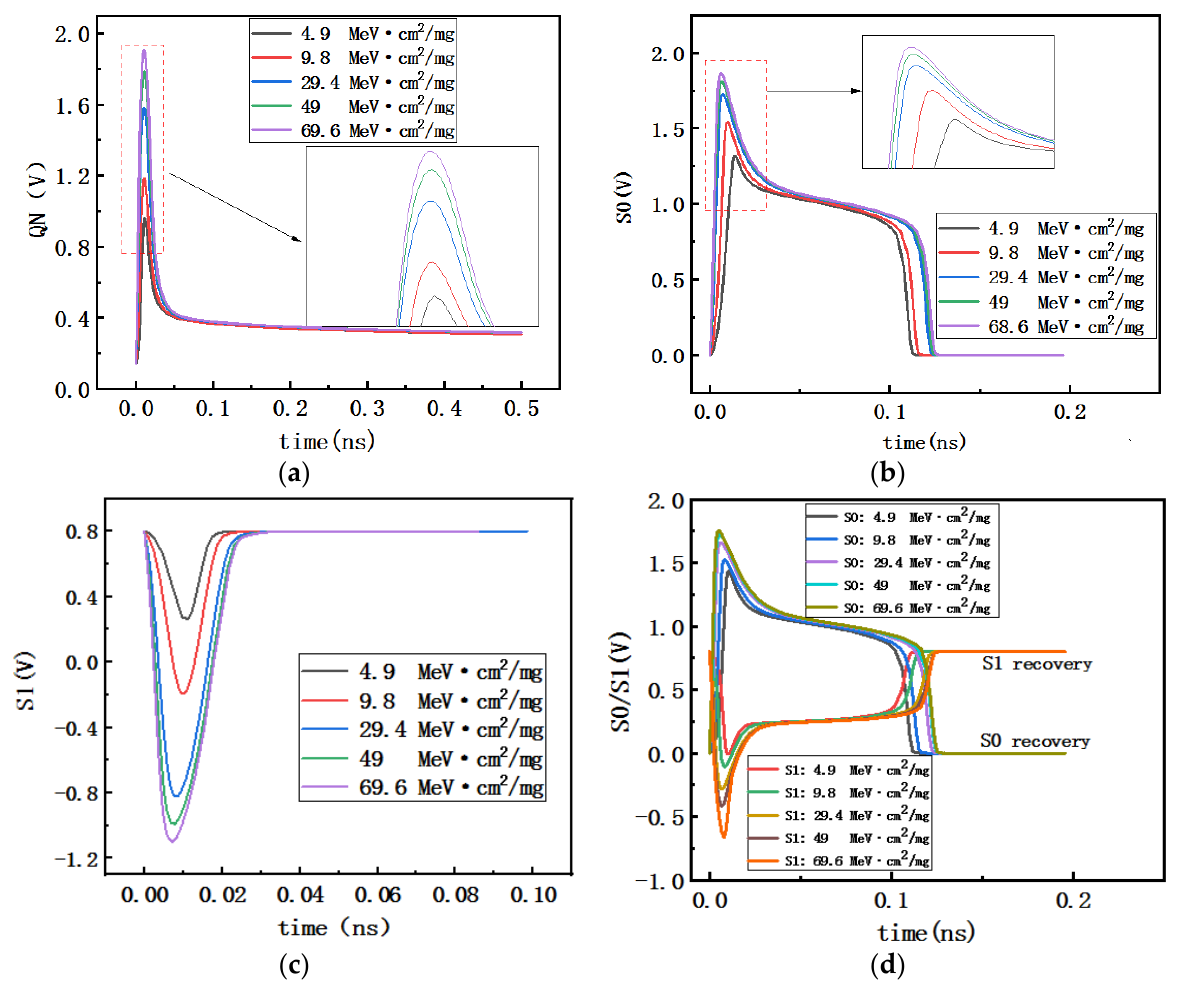
Figure 9. SEE analysis. ( a ) SEU at node QN.; ( b ) SEU at node S0; ( c ) SEU at node S1; ( d ) SEUs at node S0S1.